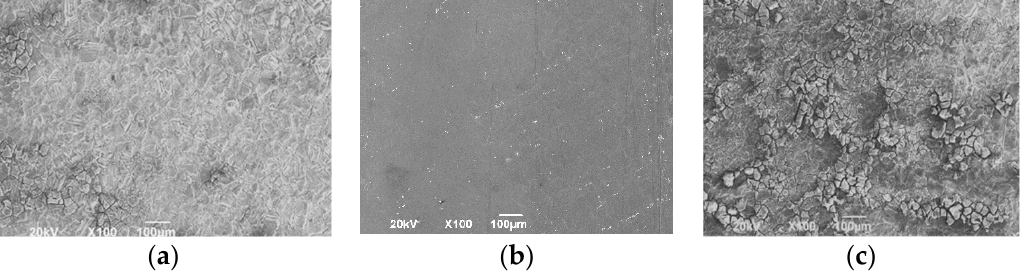
Figure 19. Surface morphology of the machined Inconel 718 channel; ( a ) the sidewall close to the inlet; ( b ) the channel hub; ( c ) the sidewall close to the outlet.